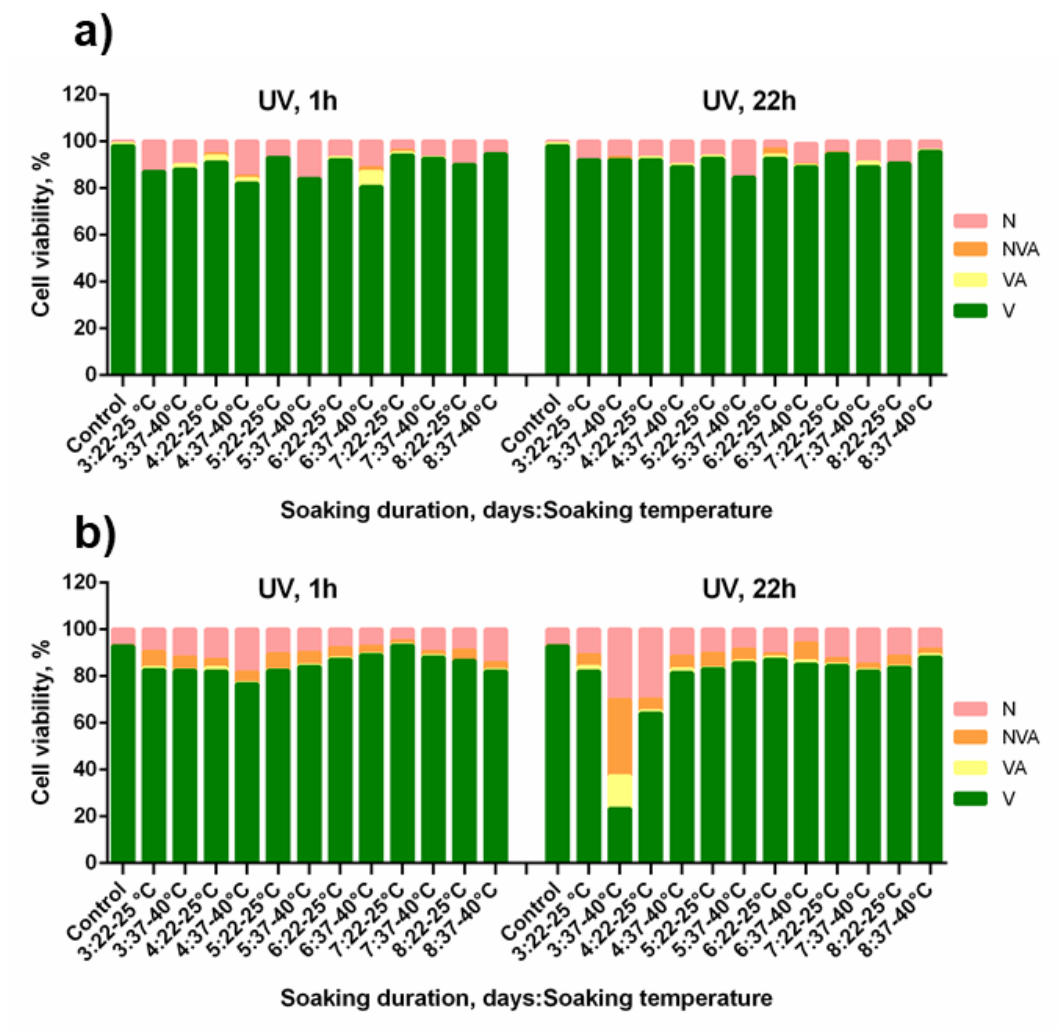
Figure 5. Cell viability results. The percentages of cells were measured after 24 h ( a ) and 48 h ( b ) post-seeding. V, viable cells; VA, early apoptosis; NVA, late apoptosis; N,